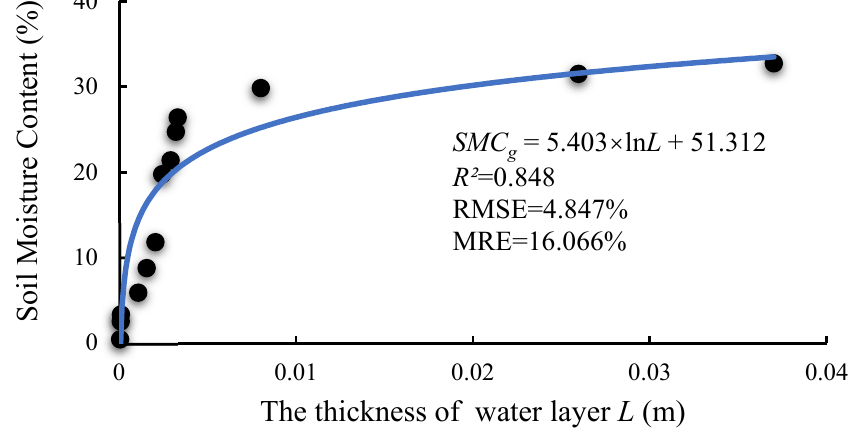
Figure 4. The relationship between SMC g and L.